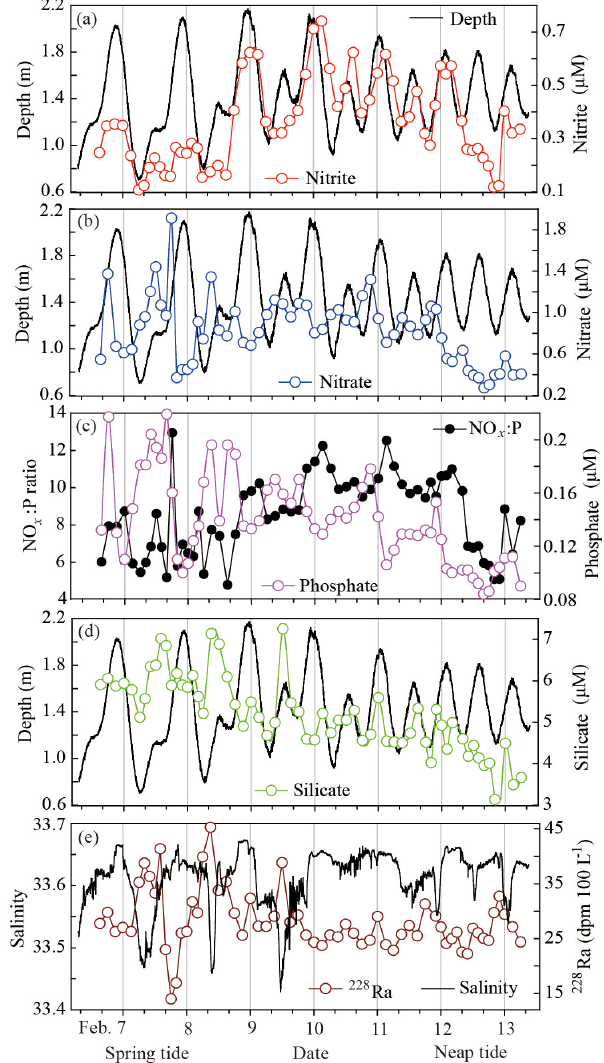
Figure 3. Time-series observations of nutrients and 228 Ra at sta- tion CT in the Luhuitou reef of Sanya Bay, China, during 6– 13 February 2012. (a) Nitrite, (b) nitrate, (c) phosphate and NO x :P ratio, (d) silicate, and (e) 228 Ra. Lines connecting the symbols are to show trends. Water depth and salinity were reported in Wang et al.